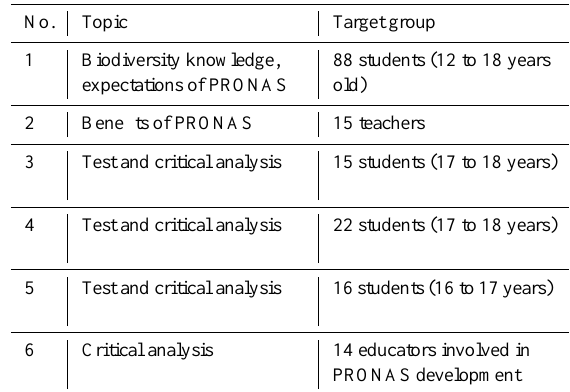
Table 1. Evaluation